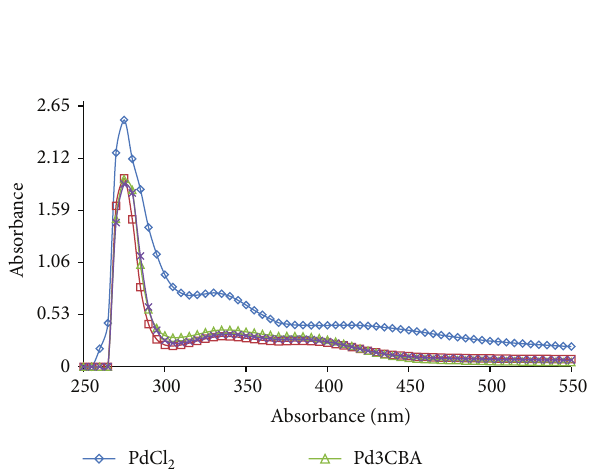
Figure 2: Structure of synthesized Pd (II) complexes.